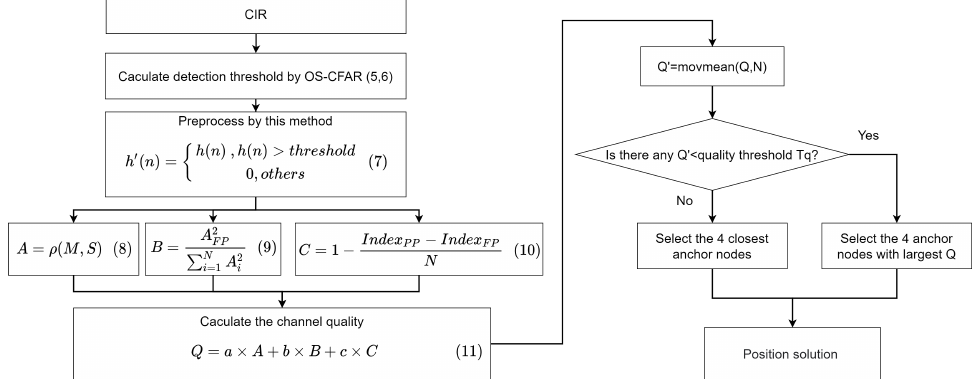
Figure 5. Anchor node selection